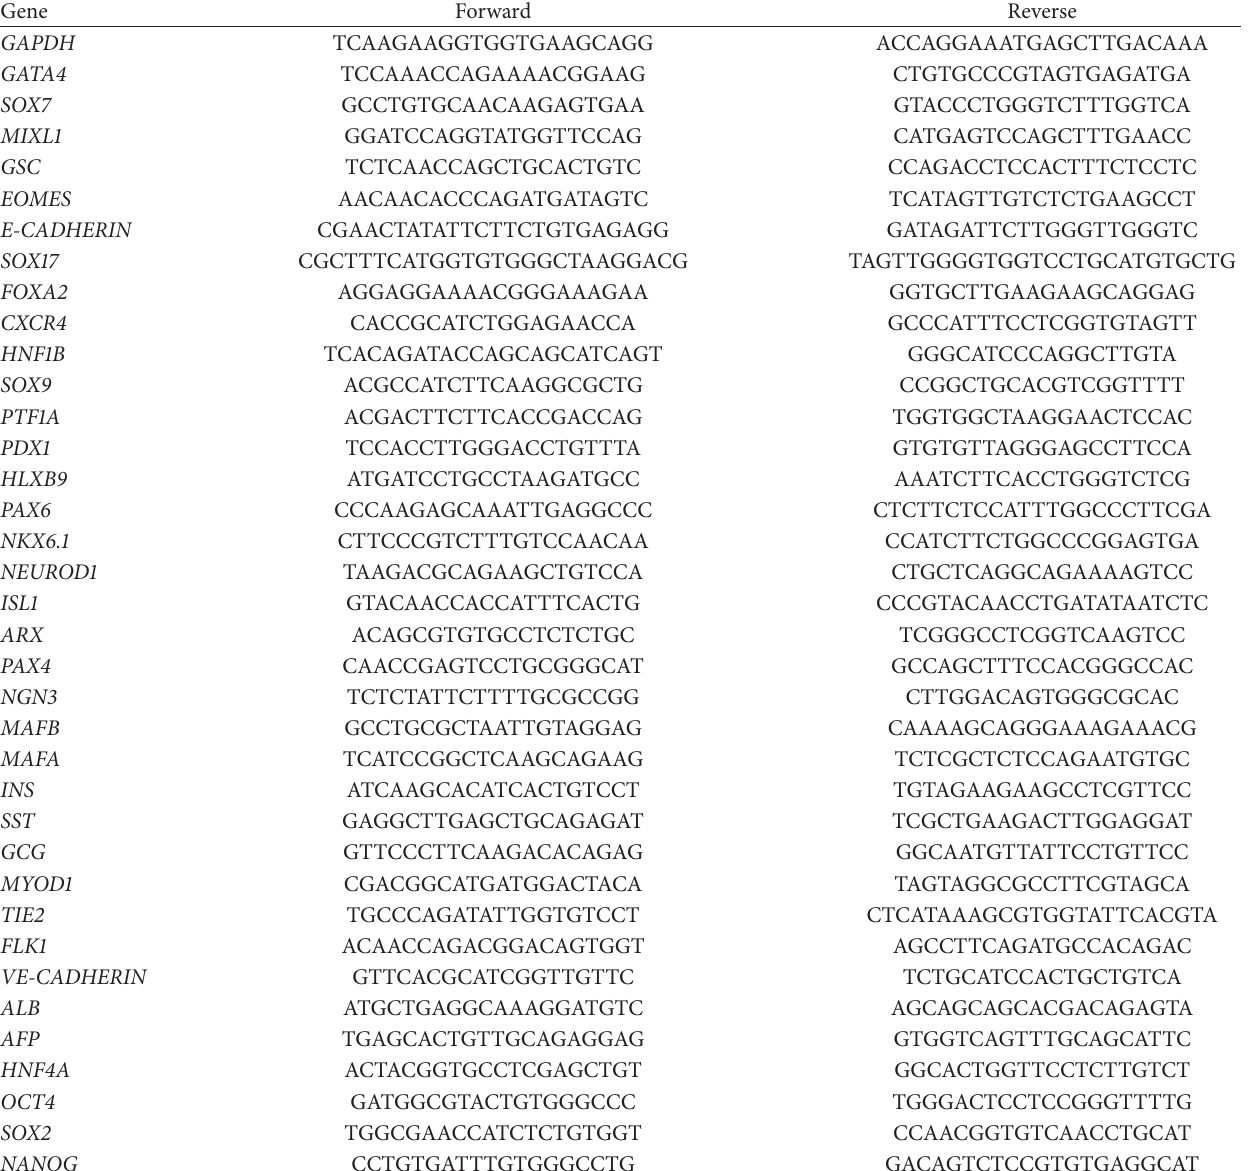
Table 1: Primers sets used for gene expression analysis by